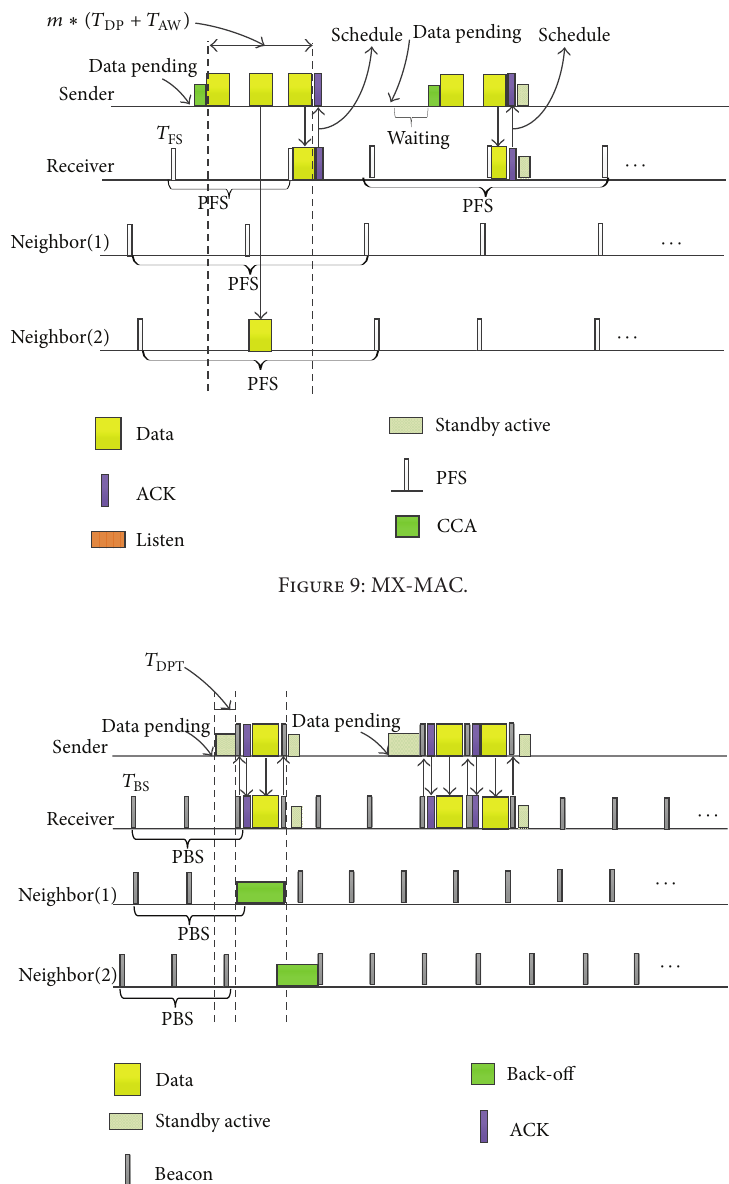
Figure 9: MX-MAC.